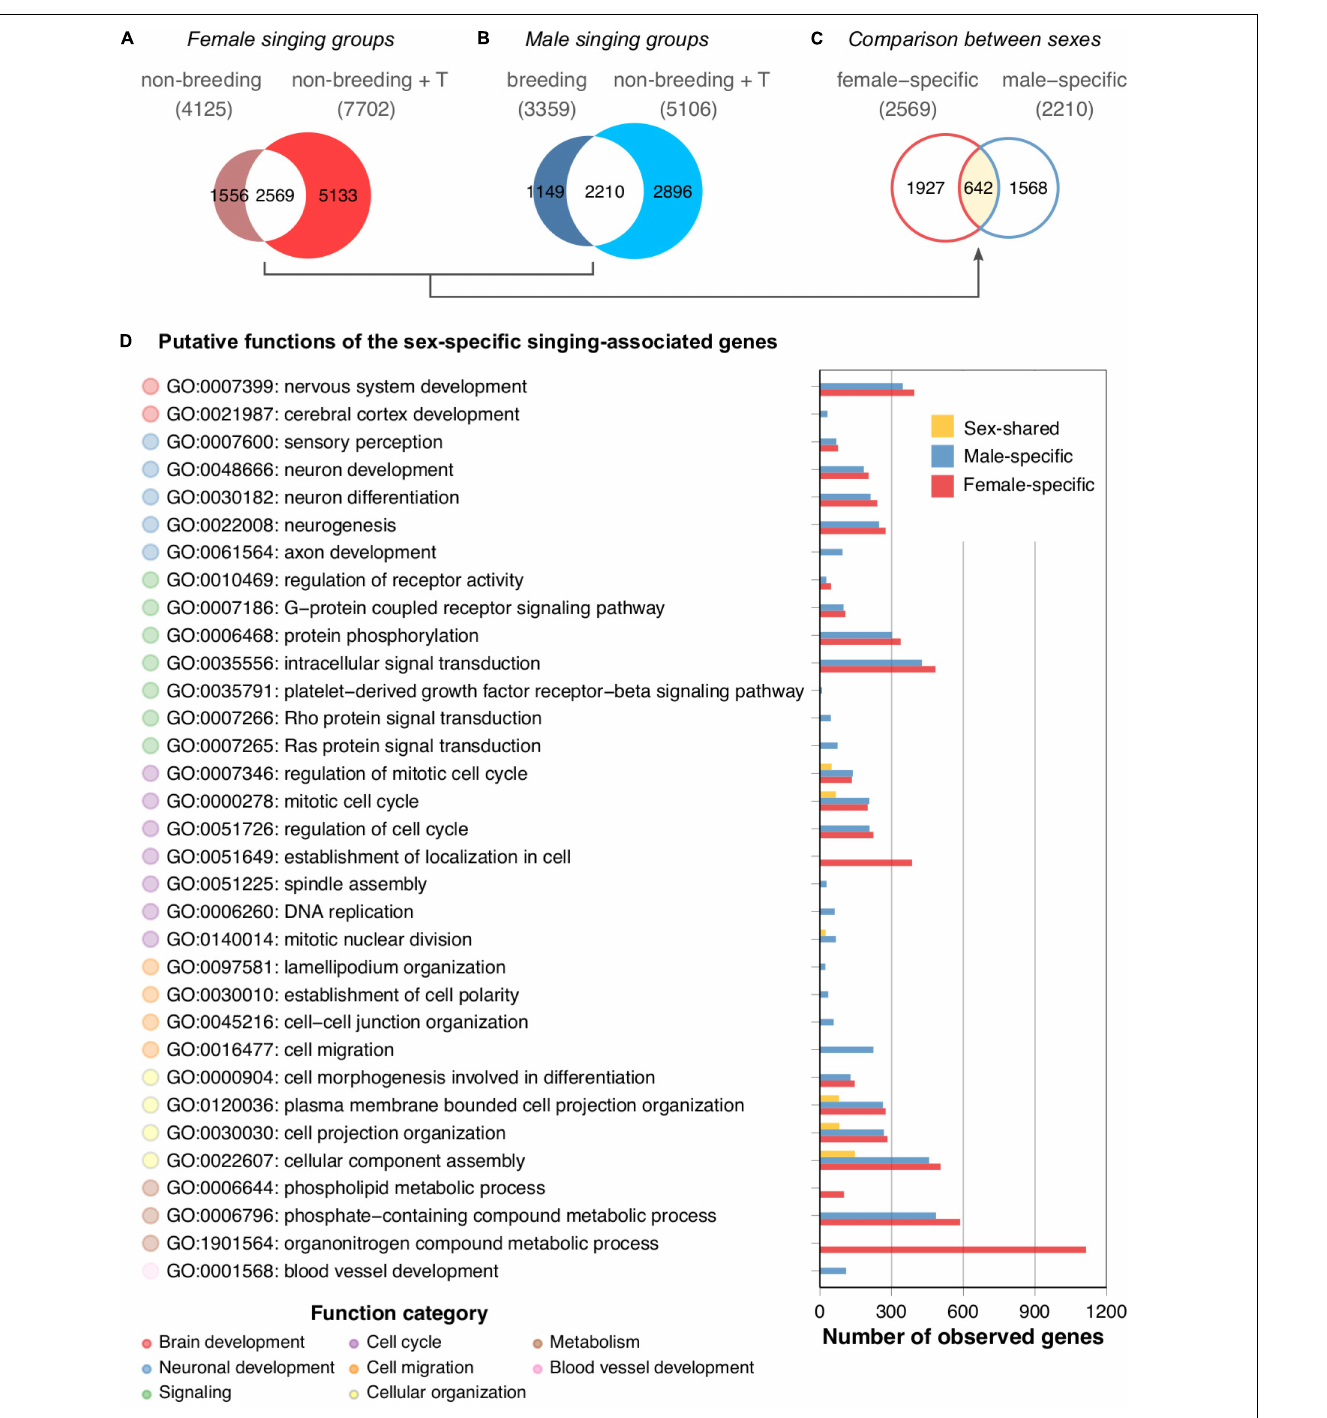
Frontiers in Neuroscience |